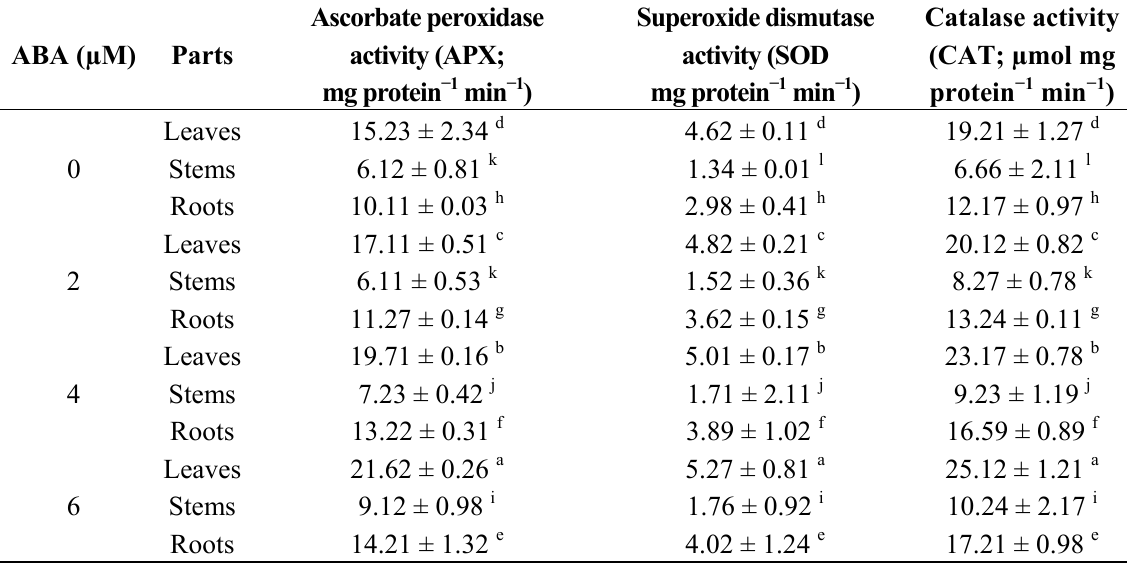
Table 4. Impact of abscisic acid levels on antioxidant enzyme activity in different parts of Orthosiphon stamineus